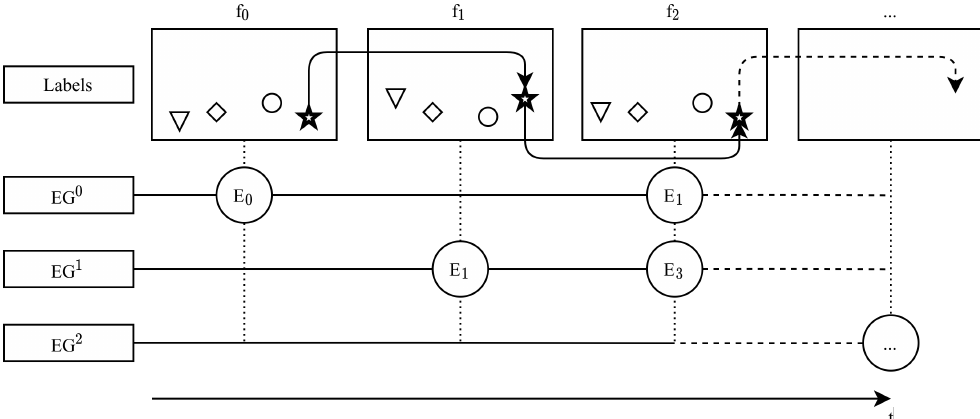
Figure 3. Overview and example of the event group annotation system. Event groups EG 0 (game state), EG 1 and EG 2 are shown as horizontal lines representing time t . Frames with spatial markers (feet positions) are shown above and numbered f 0 – f 2 . In f 0 the event E 0 (switch to rally) of EG 0 occurs. Markers are identified in time by a symbol, here shown as different shapes (e.g.,